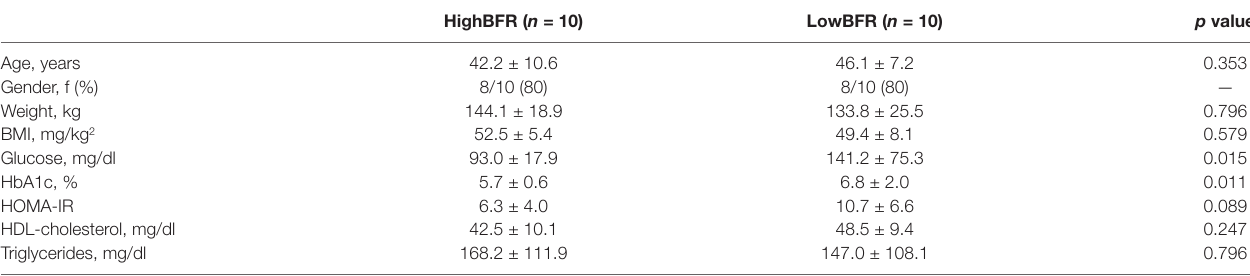
Data are means ± SD. p values were calculated for the difference between study groups using Mann–Whitney U test. p < 0.05 was considered significant. HOMA-IR, homeostasis model assessment of IR; HDL, high-density lipoprotein.